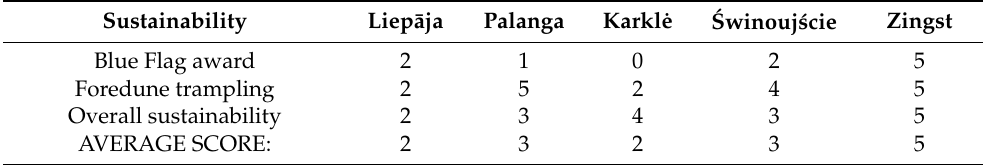
Table 5. Sustainability of the South Baltic seaside resorts (scores from 1—poor to 5—excellent). Sustainability Liep¯aja Palanga Karkl˙e ´Swinouj´scie Zingst Blue Flag award 2 1 0 2 5 Foredune trampling 2 5 2 4 Overall sustainability 2 AVERAGE SCORE: